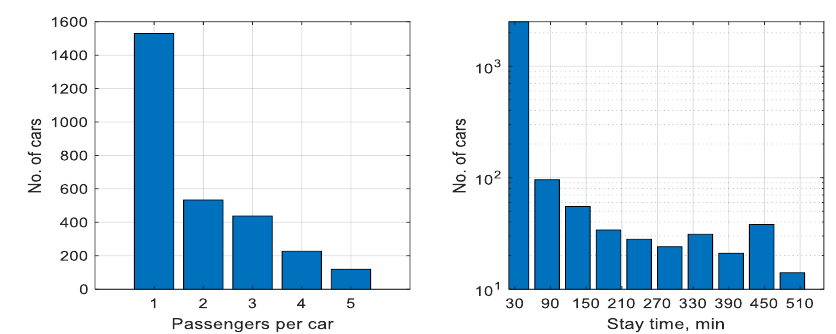
Figure 5: Histograms of Average users over a day, (a) the average number of passengers per car, and (b) the average stay time of the cars.